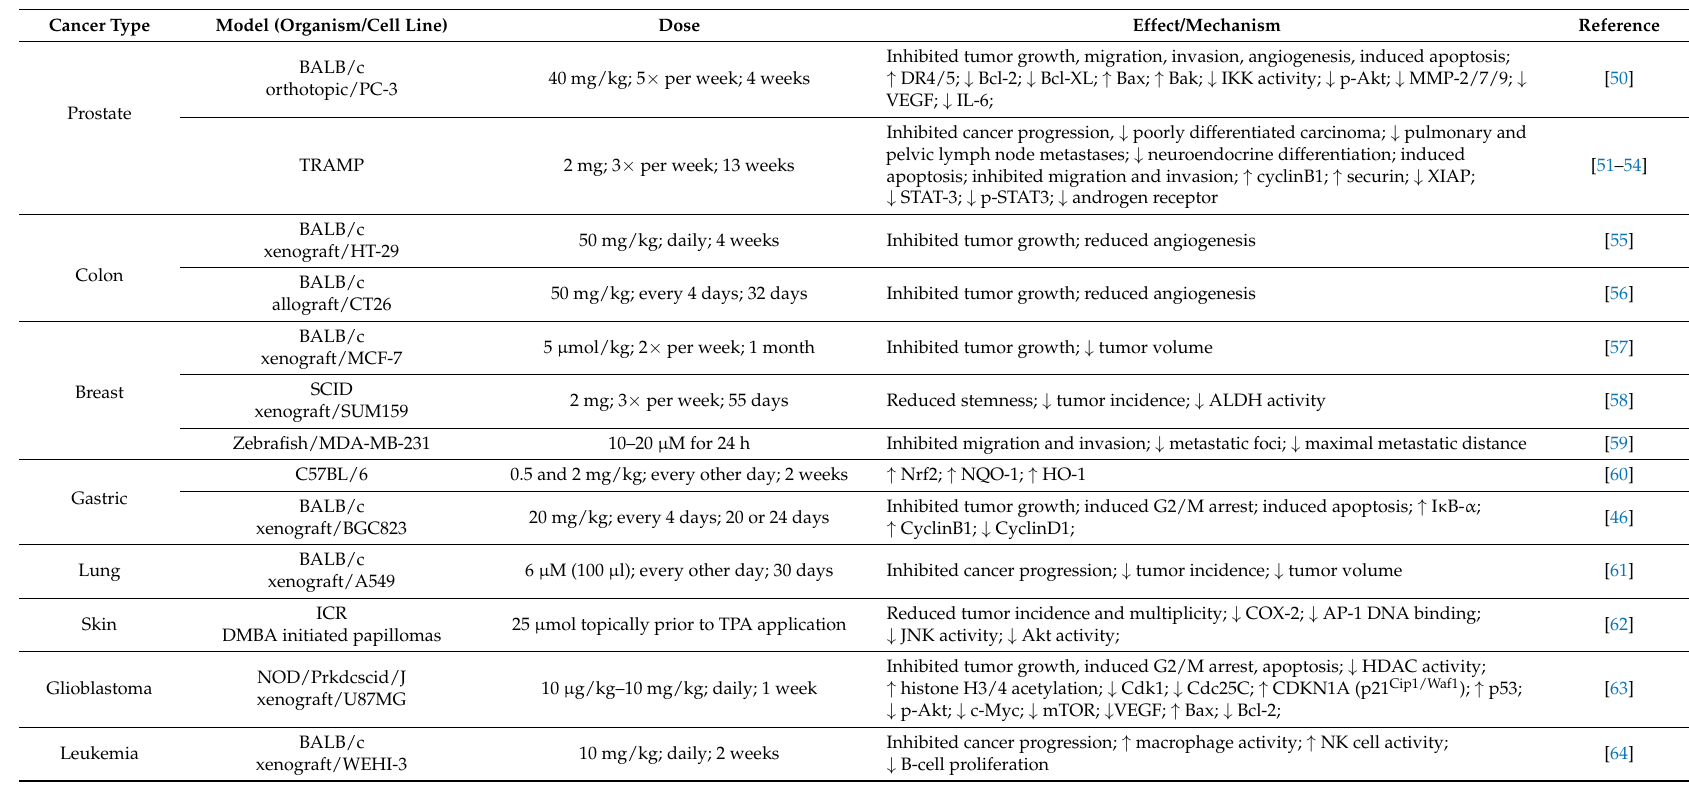
Table 1. Summary of in vivo mechanisms of action of